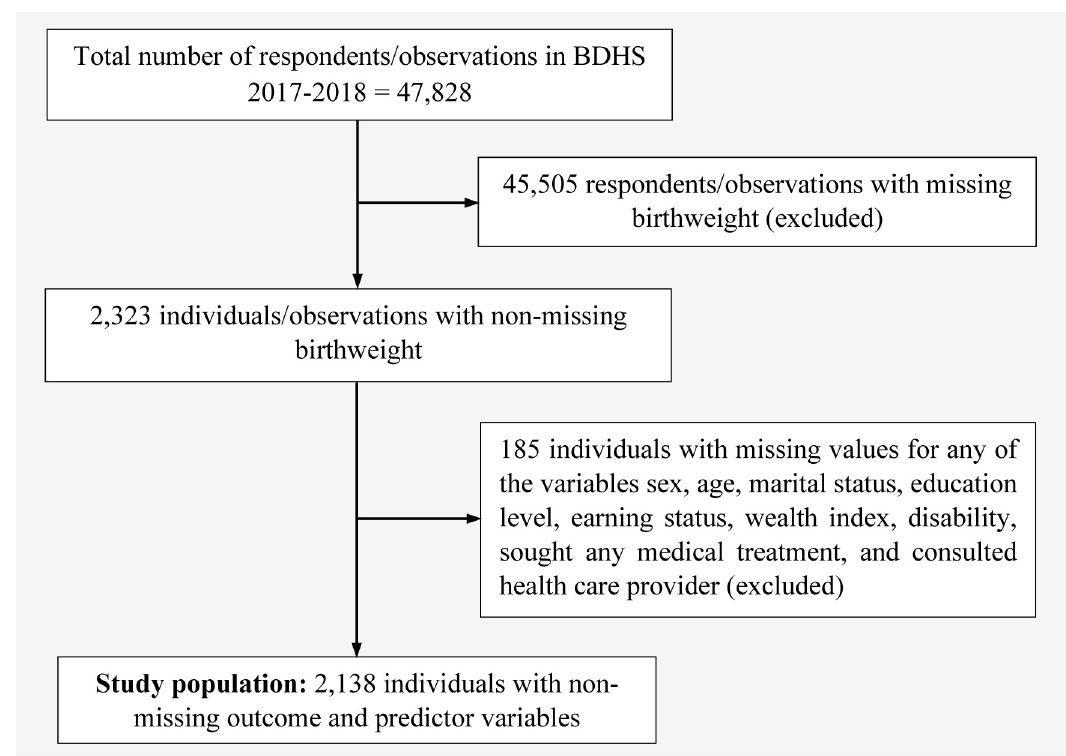
Fig 1. Study flowchart of inclusion/exclusion of